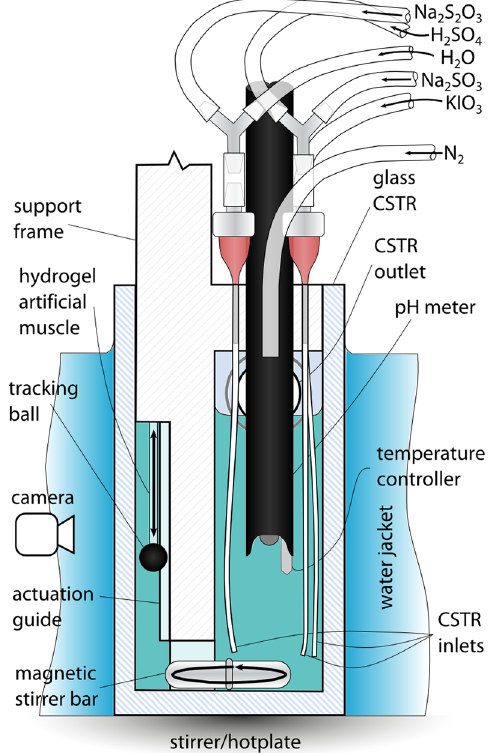
Figure 2. CSTR. Cross-sectional diagram depicting the experimental arrangement of the CSTR